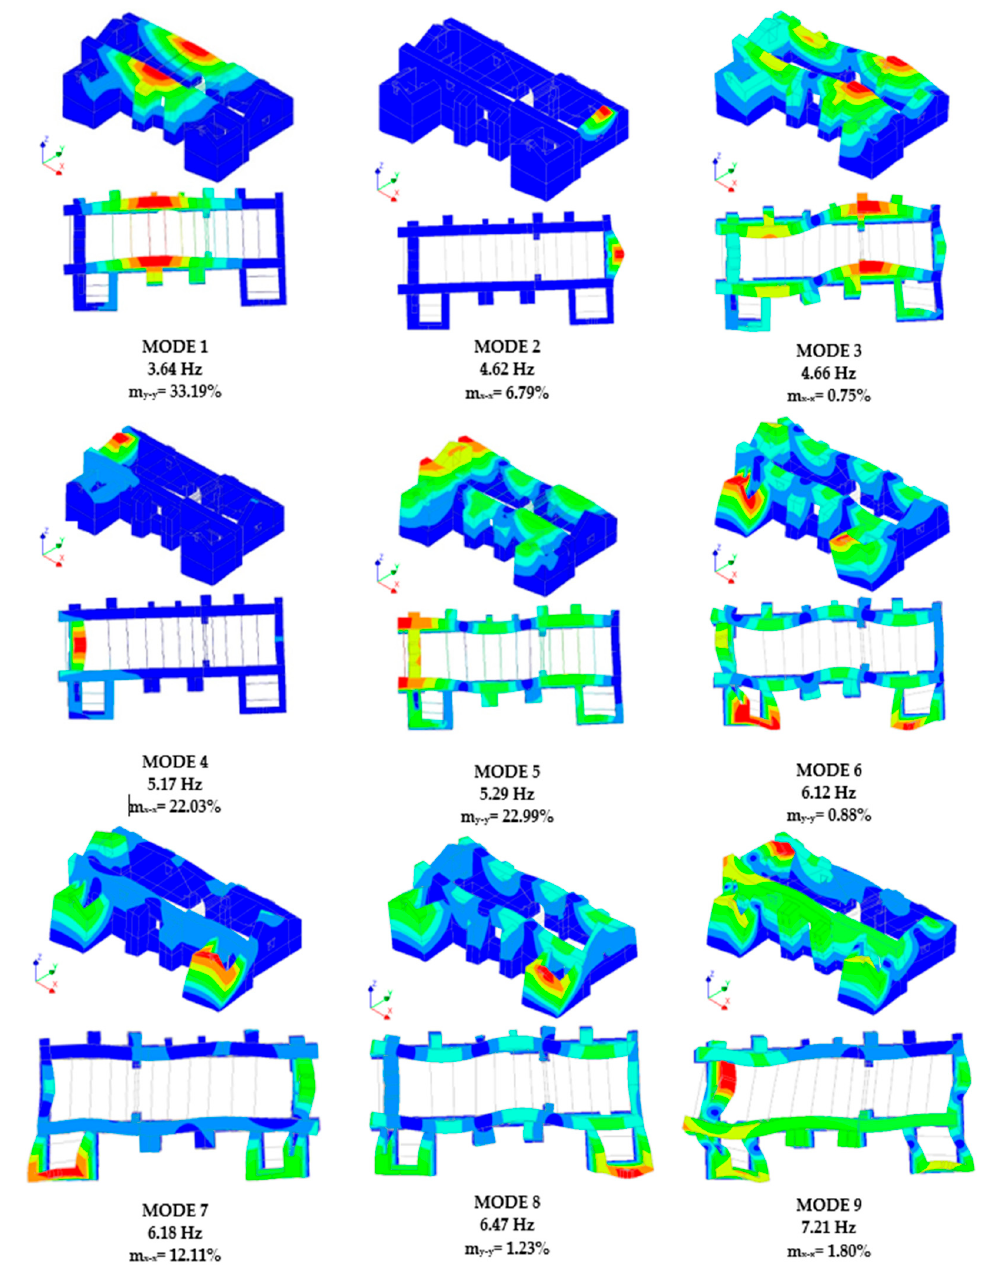
Figure 16. Selected modes from the modal analysis, for the retrofitted model MODEL_2.